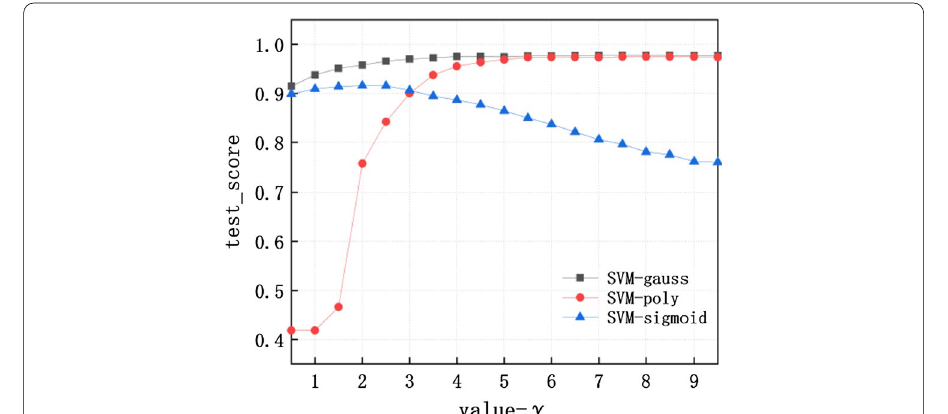
Fig. 15 The accuracy of classification changed with the value of c